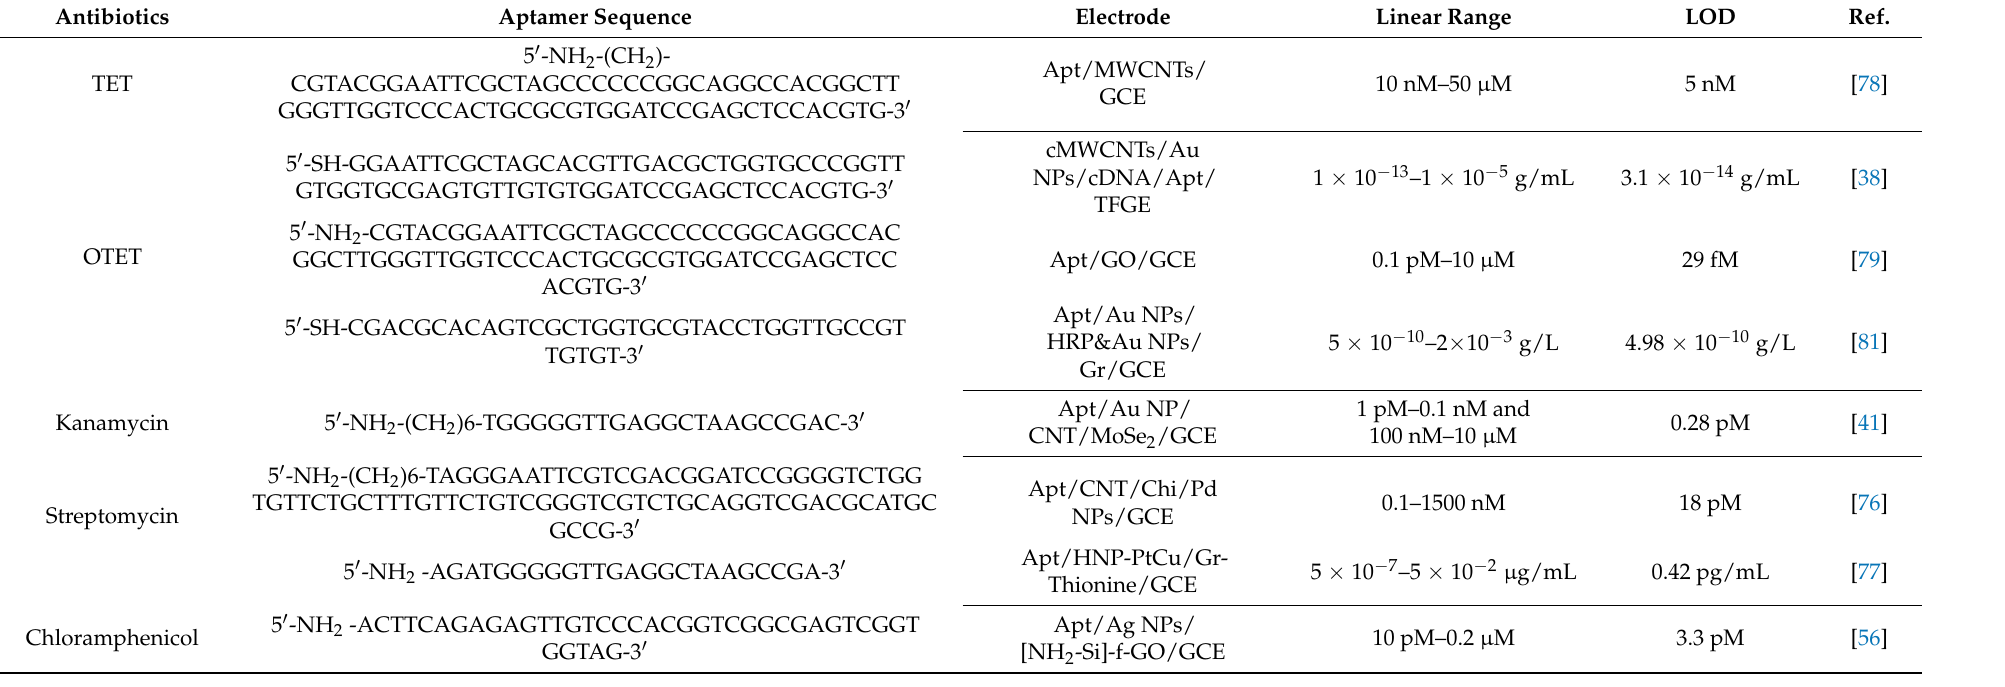
Table 3. CNMs-based aptasensors for